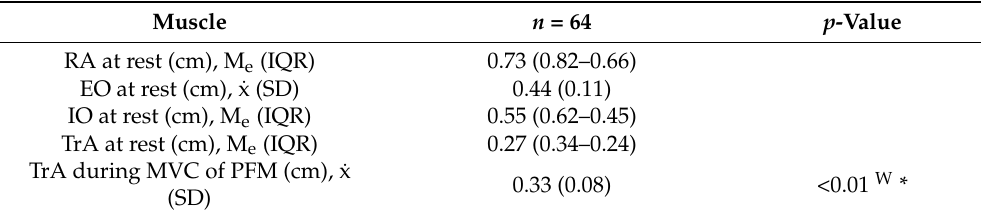
M e , median; IQR, interquartile range; ˙x, mean; SD, standard deviation; RA, rectus abdominis muscle; EO, external oblique muscle; IO, internal oblique muscle; TrA, transverse abdominis muscle; MVC, maximal voluntary contraction; PFM, pelvic floor muscles. W Wilcoxon test. * statistically